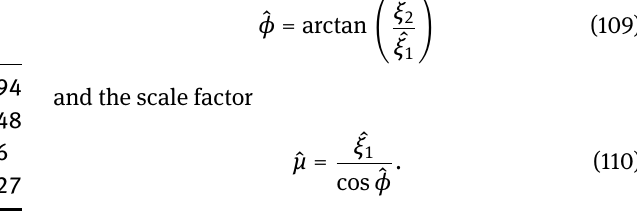
Table 13: Example dataset for the 2D similarity transformation Point no.